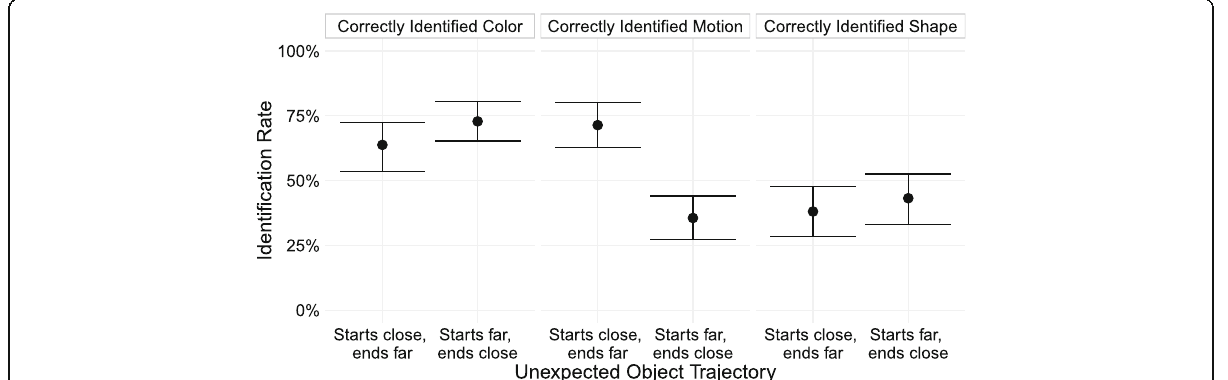
Fig. 5 Rate at which subjects who reported seeing a new object identified the unexpected object ’ s features, broken down by the unexpected object ’ s trajectory. Error bars are 95% bootstrapped confidence intervals. To be counted as correctly identifying a feature of the unexpected object, subjects had to report noticing something new, and: for color, report that the new object was green; for motion, select the correct trajectory from the cardinal and inter-cardinal directions; and for shape, report that it was a